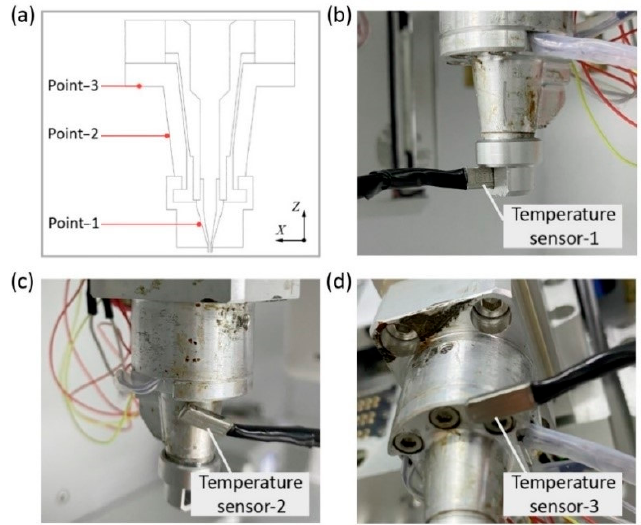
Figure 7. Monitor points and the experiment setup. ( a ) locations of the observing points; ( b ) temperature sensor for point-1; ( c ) temperature sensor for point-2; ( d ) temperature sensor for point-3.